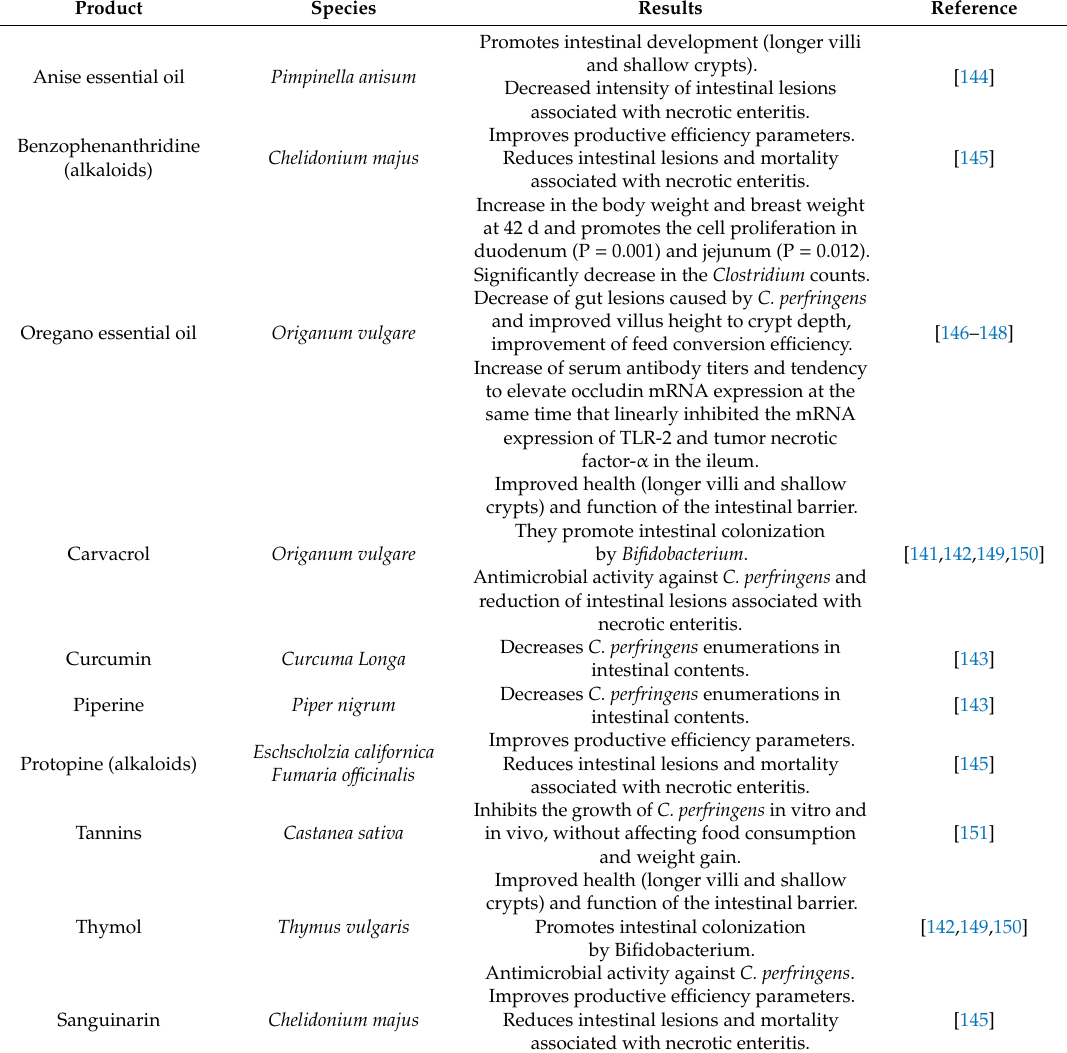
Table 8. Phytogenics used in the control of Clostridium perfringens in broilers. Results